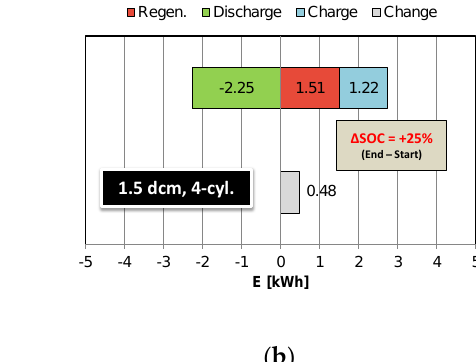
Figure 2. Energy flow values during the test drives: ( a ) newer solution with the 3-cylinder engine; ( b ) older solution with the 4-cylinder engine.